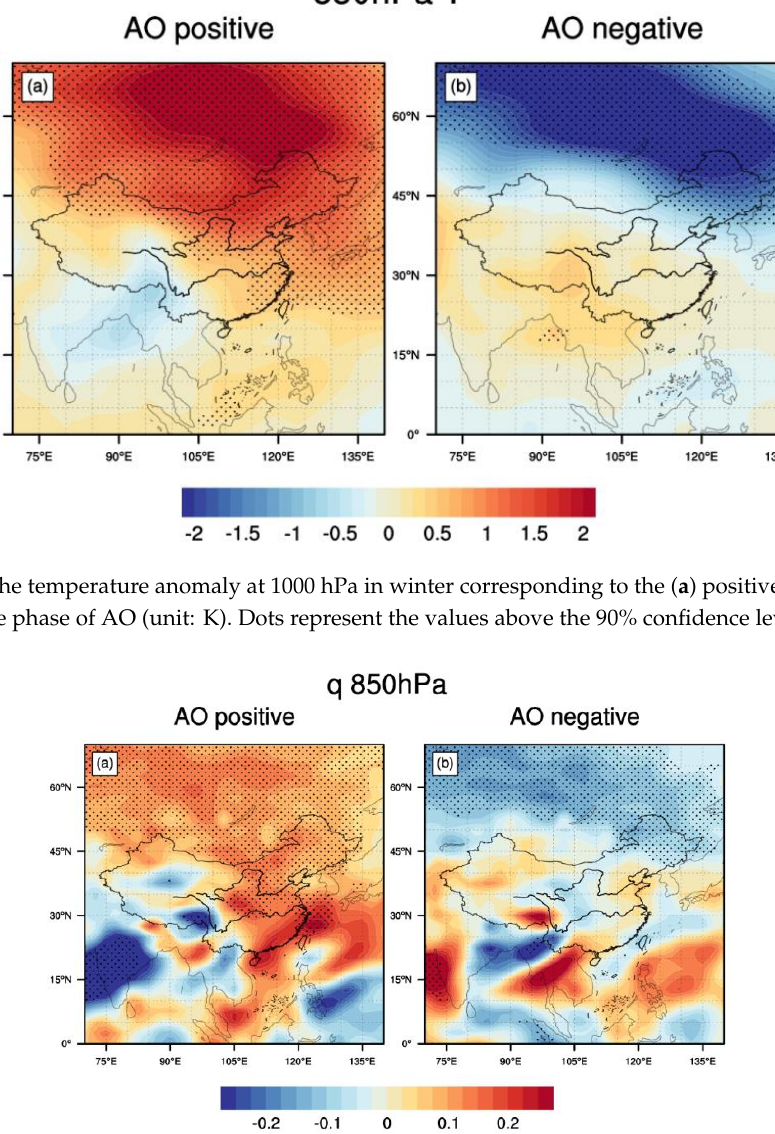
Figure 6. The same as Figure 5, but for the water vapor field at 1000 hPa (unit: g/kg). Dots represent the values above the 90% confidence level.